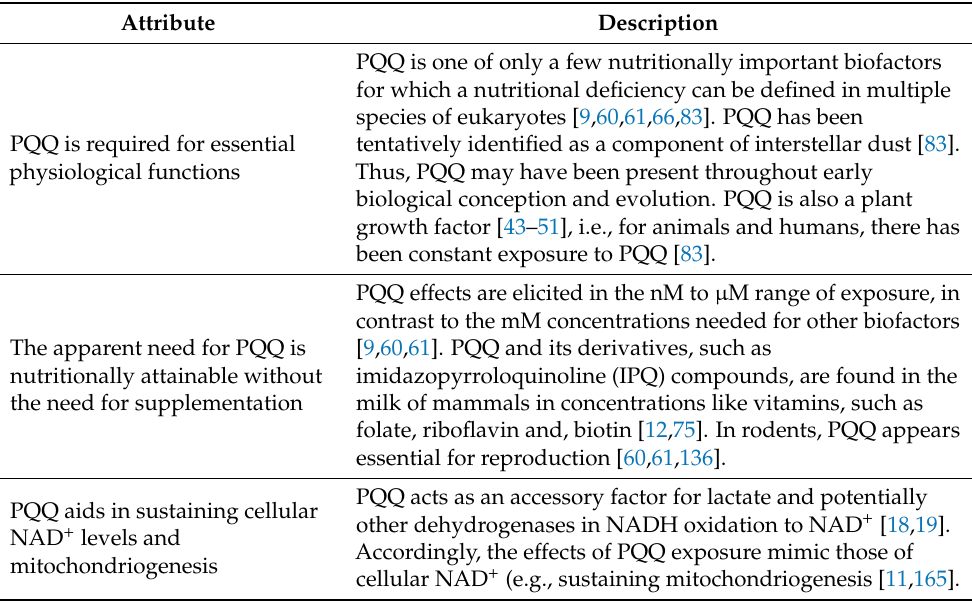
Table 1. Pyrroloquinoline Quinone: Novel